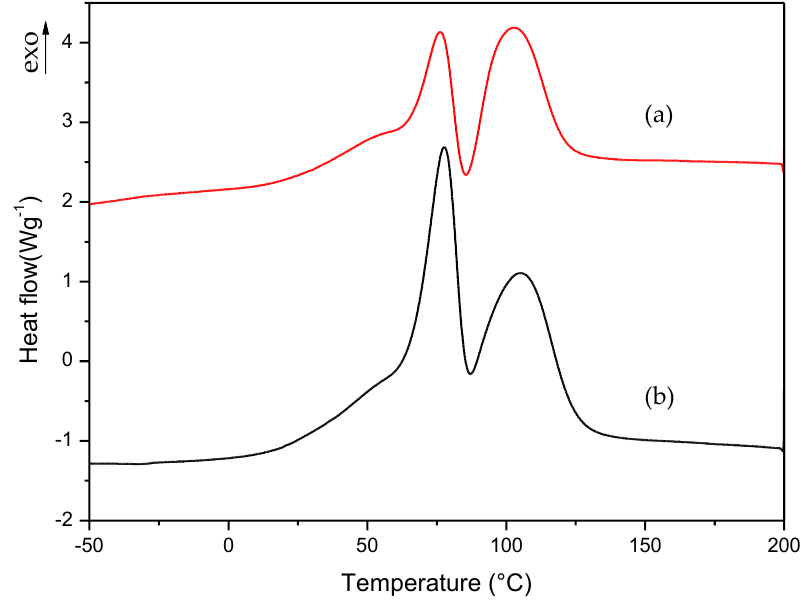
Figure 4. Dynamic DSC curves for curing process of (a) commercial and (b) A formulations.